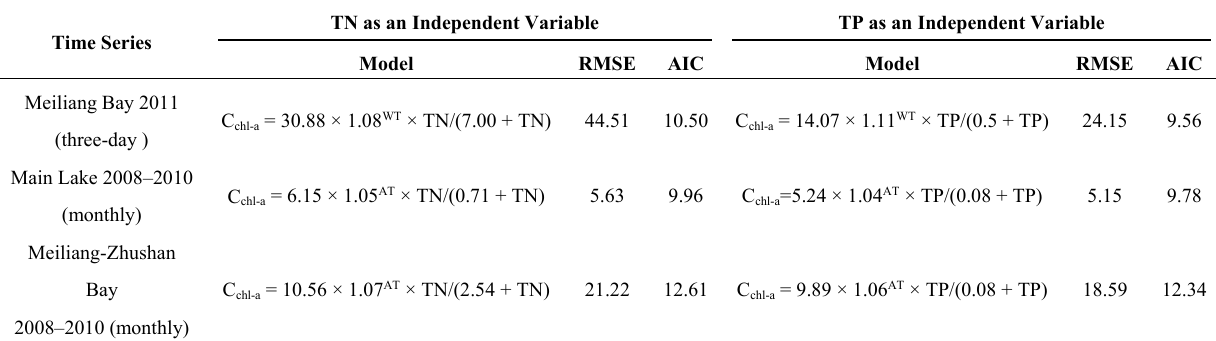
Table 2. Validated parameters, root mean square error (RMSE) and akaike information criterion (AIC) values fitted to the modified Monod model for selected datasets 1